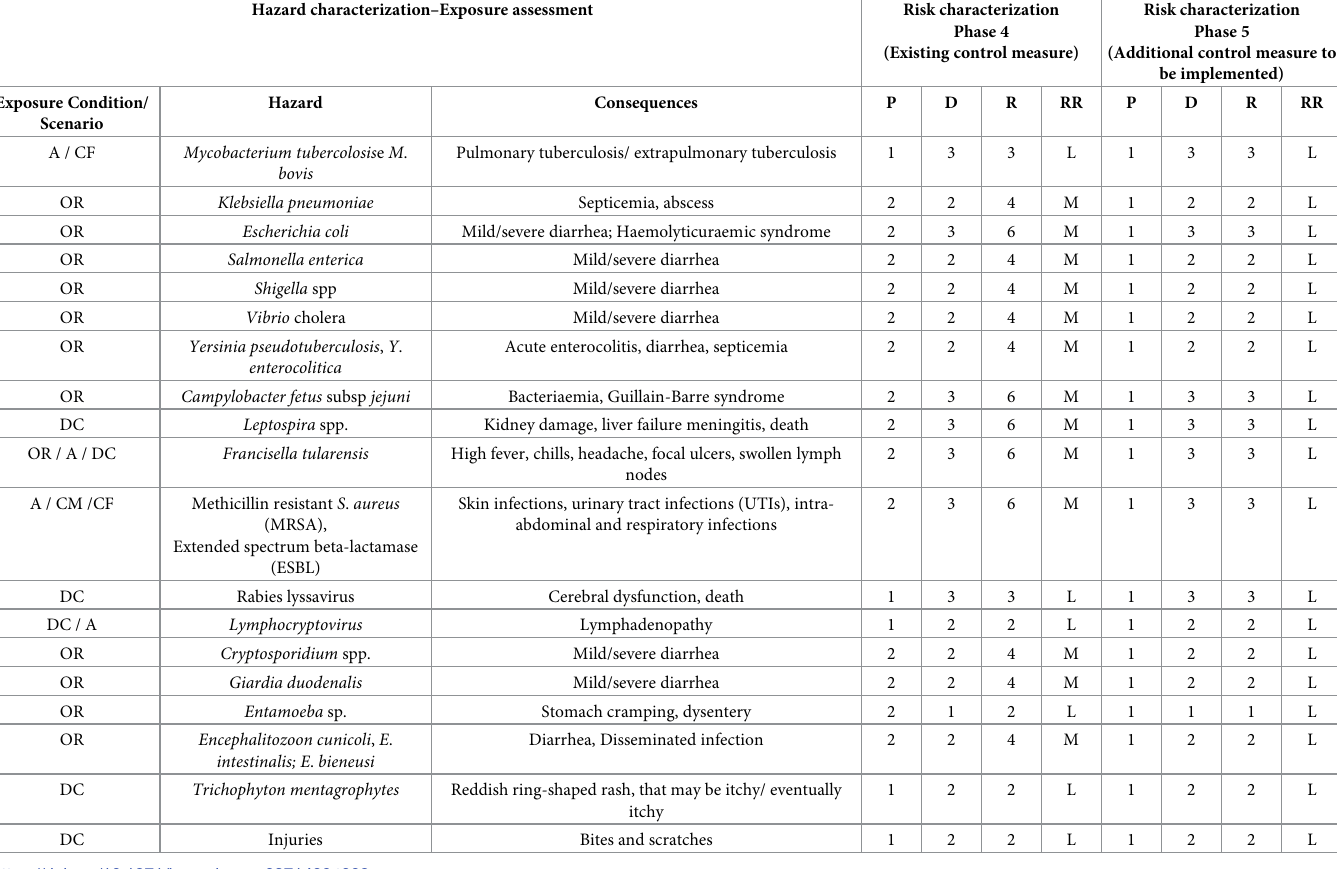
Table 3. List of relevant zoonosis in lemurs and other animals reported for animal-visitor interactions (detailed in Table B in S2 Appendix). Values of risk character- ization for existing control measure and additional control measure to be implemented (phase 2–5). (P = probability; D = damage; R = risk score; RR = risk rating; OR = Oral route; DC = Direct contact; A = Aerosol; CM = Contact with infected material and ingestion; CF = Contact with body fluids; L = Low; M = Medium; H = High). Hazard characterization–Exposure